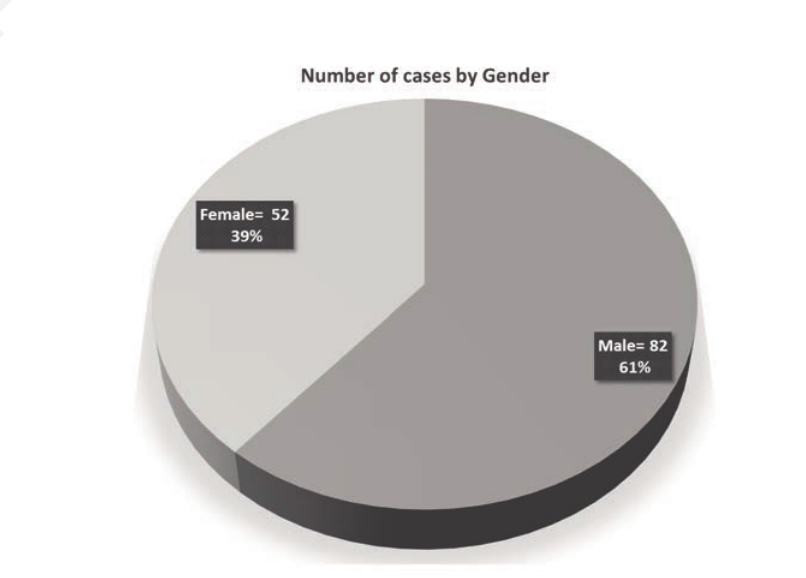
Figure 2. Number of cases by gender